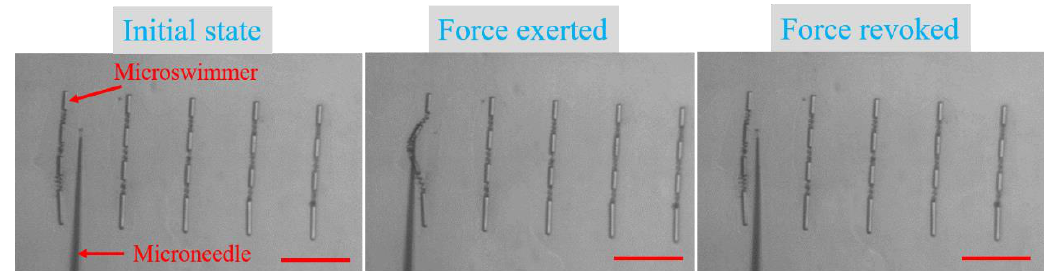
Figure 4. Tests of the structural integrity of the microswimmer. The scale bar is 100 μm for all images. Please refer to Video S1.